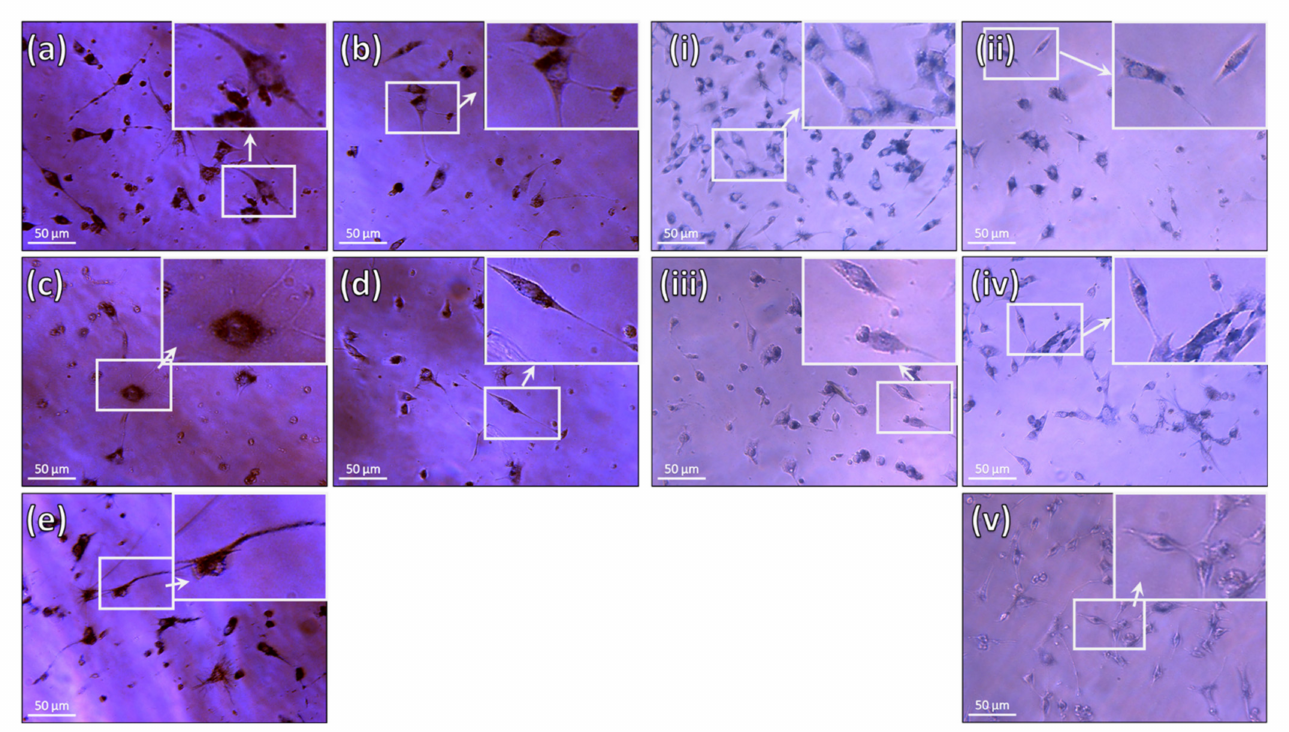
Figure 6. Fibroblasts post-MTT observed with OPCM at 3 days ( a – e ) and 5 days ( i – v ) of incubation (200 × ): ( a , i ) control; ( b , ii ) conditioned medium with AISI 316L steel eluates; ( c , iii) conditioned medium with a-C:5H coating eluates; ( d , iv ) conditioned medium with a-C:10H coating eluates; ( e , v ) conditioned medium with artificial